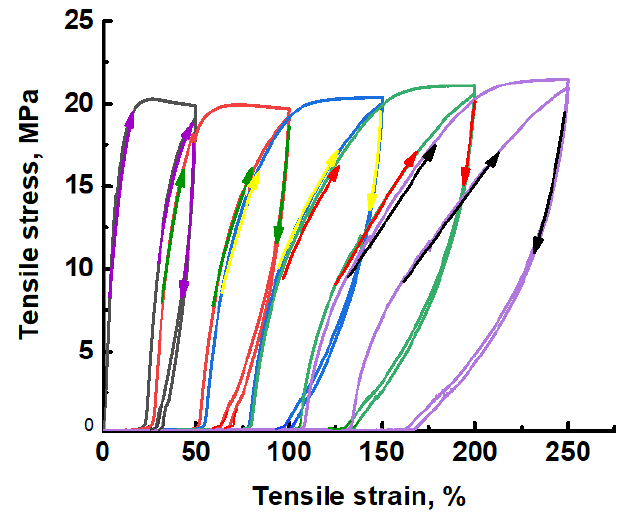
Figure 7. Stress-strain curves illustrating the cyclic loading/unloading for the UHMWPE films in the PALE (O/W emulsion based on n -heptane and water, 95 vol. % of water).